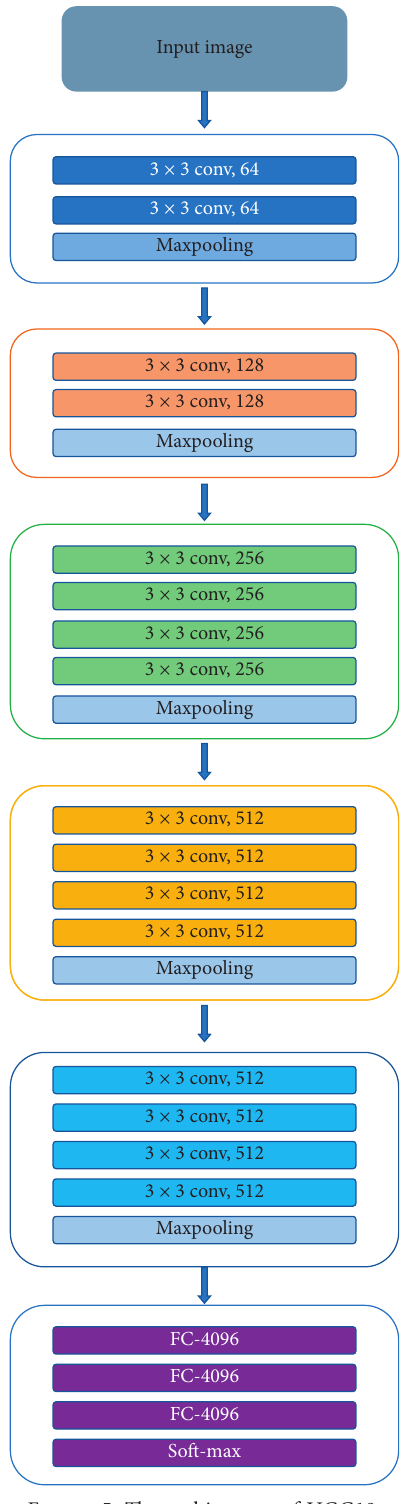
Figure 5: The architecture of